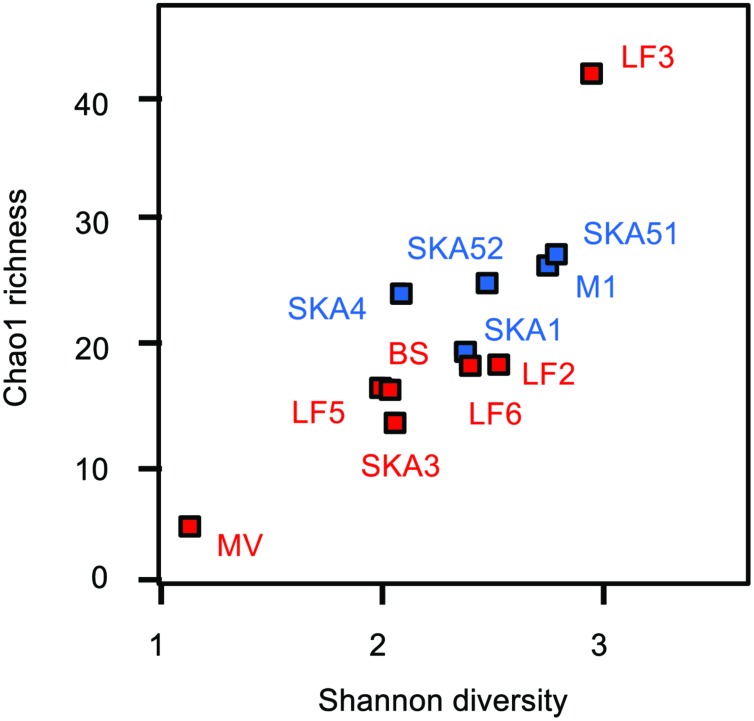
MasD/assA gene sequence diversity and richness indices. Red symbols: seepage sediments, blue symbols: pristine sediments. Indices for MV enrichments are not shown (please refer to Supplementary Table S2).